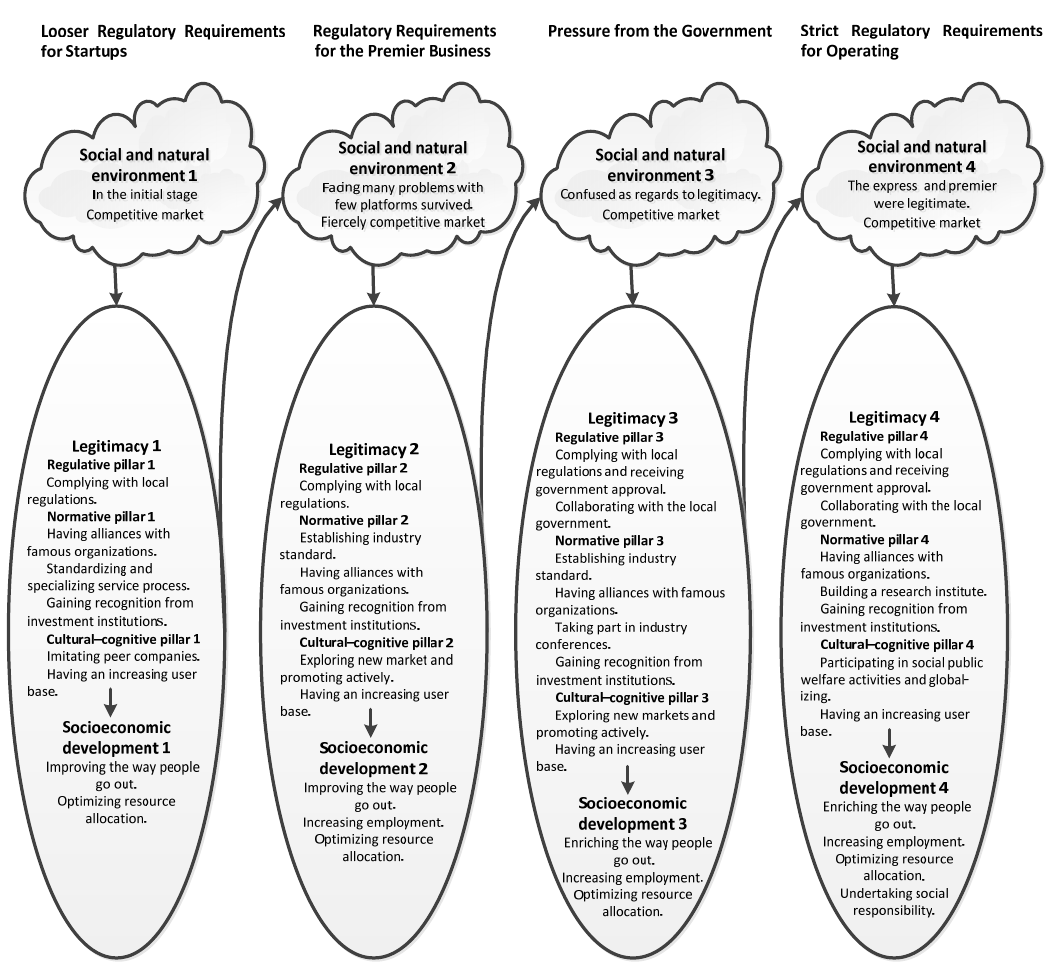
Figure 2. DiDi’s legitimacy for socioeconomic development.